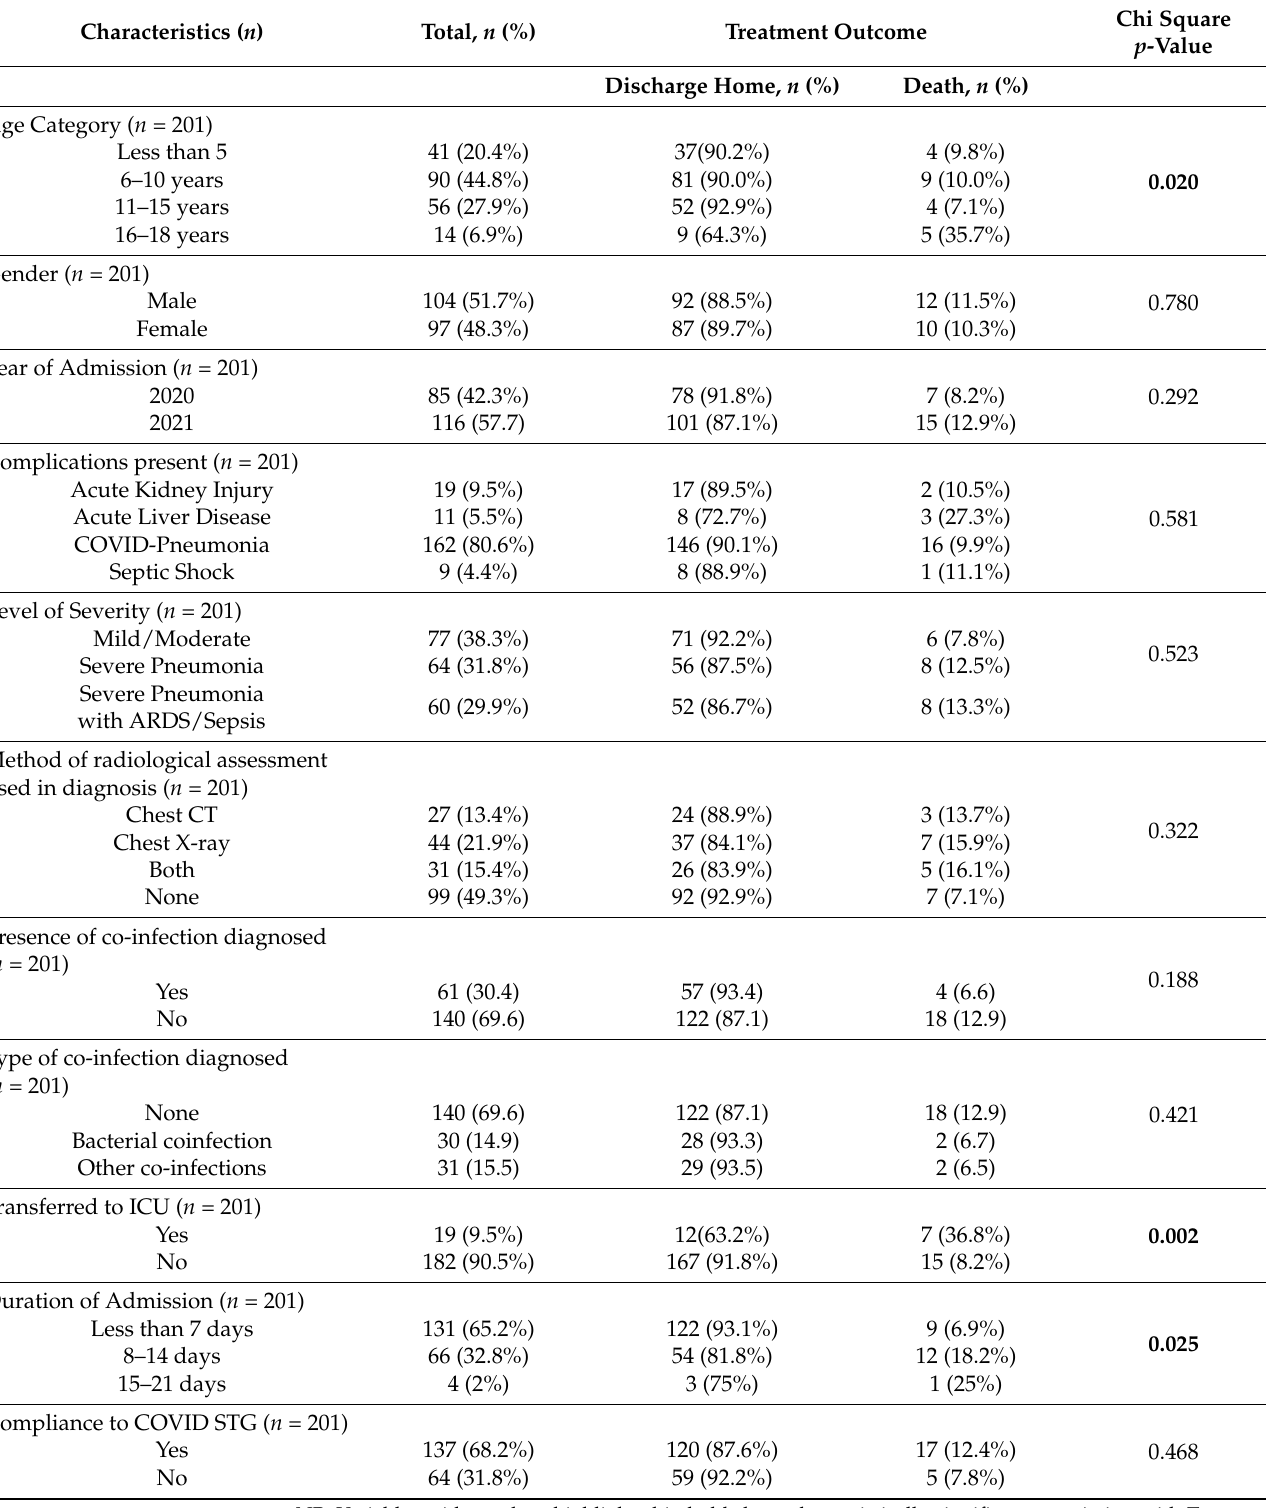
Table 2. Association between treatment outcomes and patients’